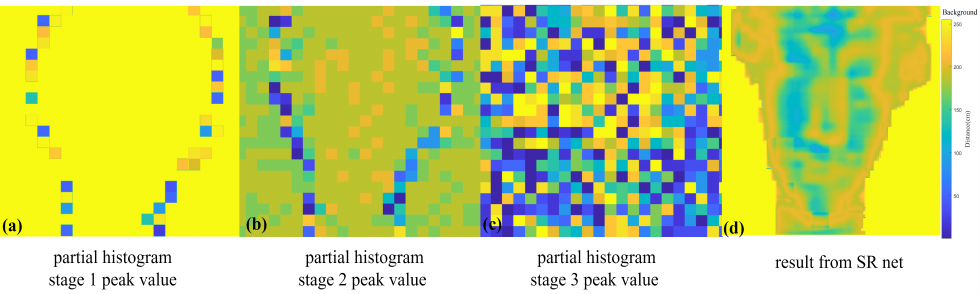
Figure 7. Test results in the lab: ( a – c ) Peak values of multi-scale histogram bins in 3 stages. ( d ) Result of target statue after application of SR-Net.